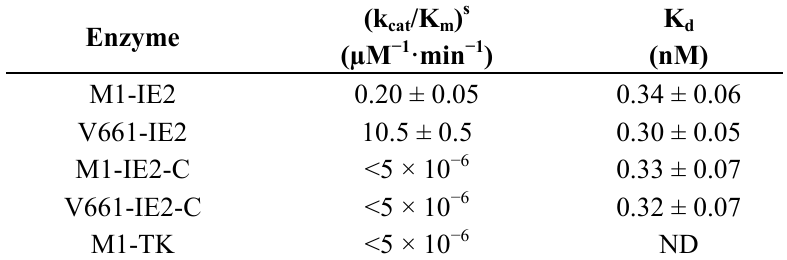
Table 1. Overall cleavage rate [(k with substrate